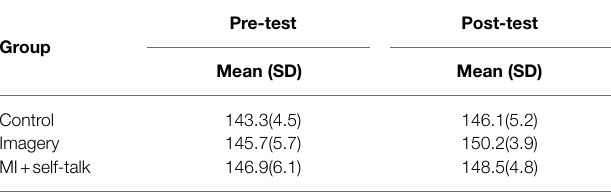
TABLE 1 | Mean (standard deviation) first service ball speed (km/h) for the control, MI and MI + self-talk groups during pre- and post-test (all ps > 0.05).